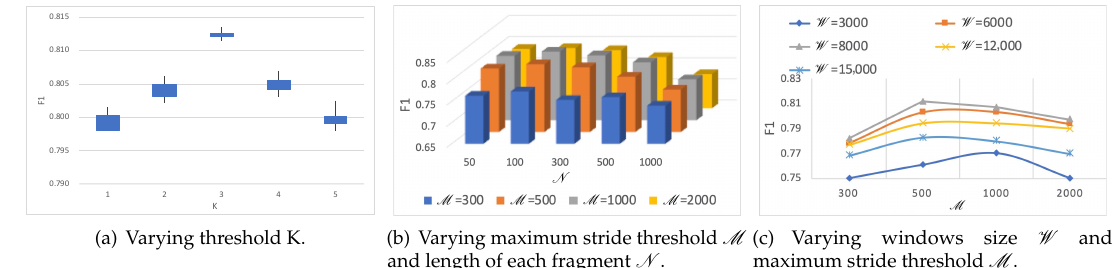
Figure 10. F 1 score results of KEEN for for different